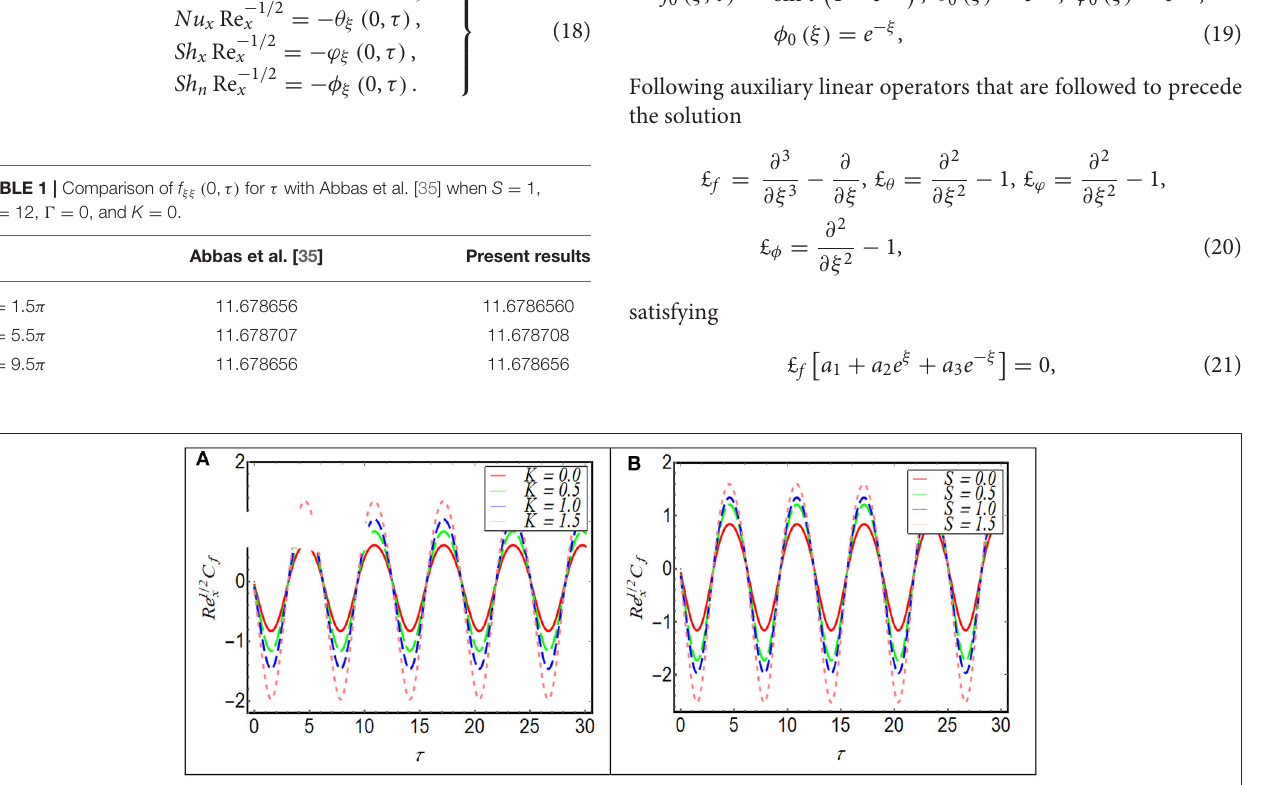
FIGURE 2 | Impact of (A) K (B) S on skin friction coefficient.